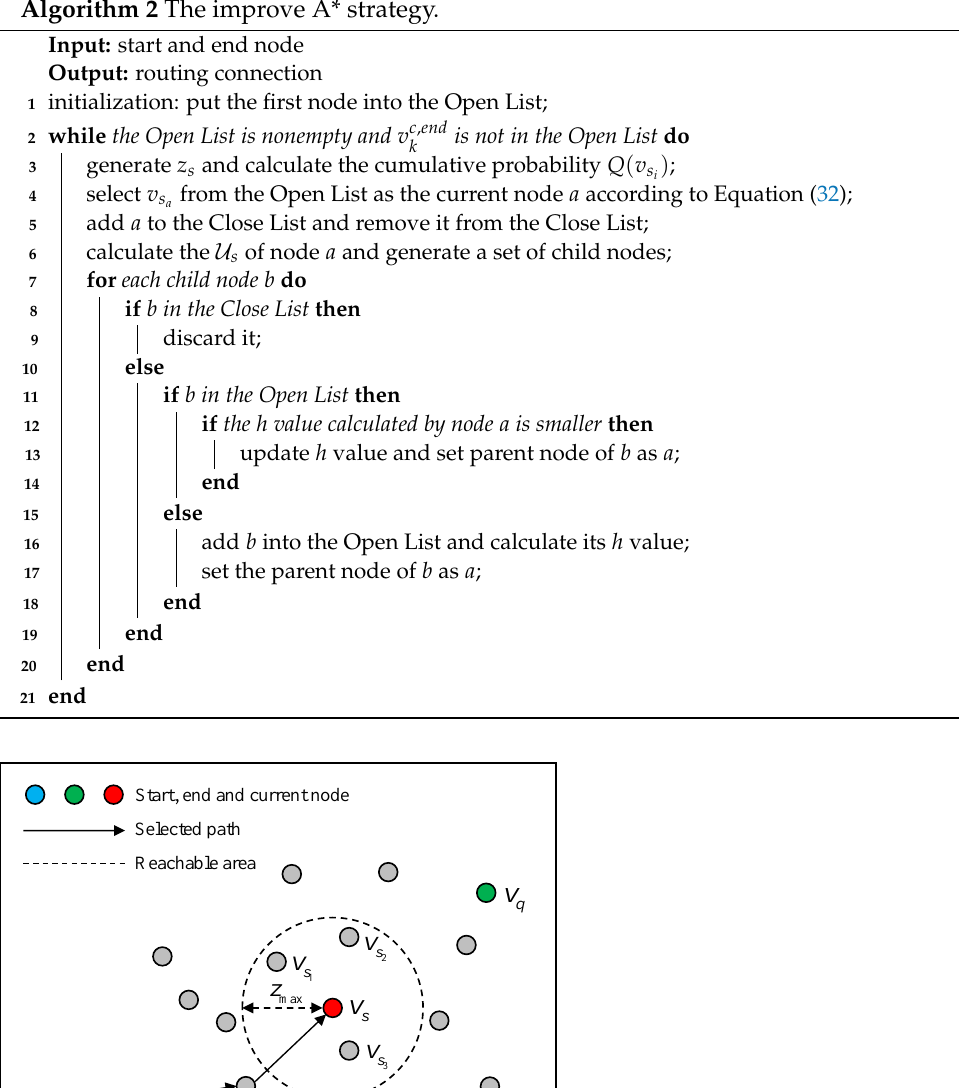
Algorithm 2 The improve A* strategy.